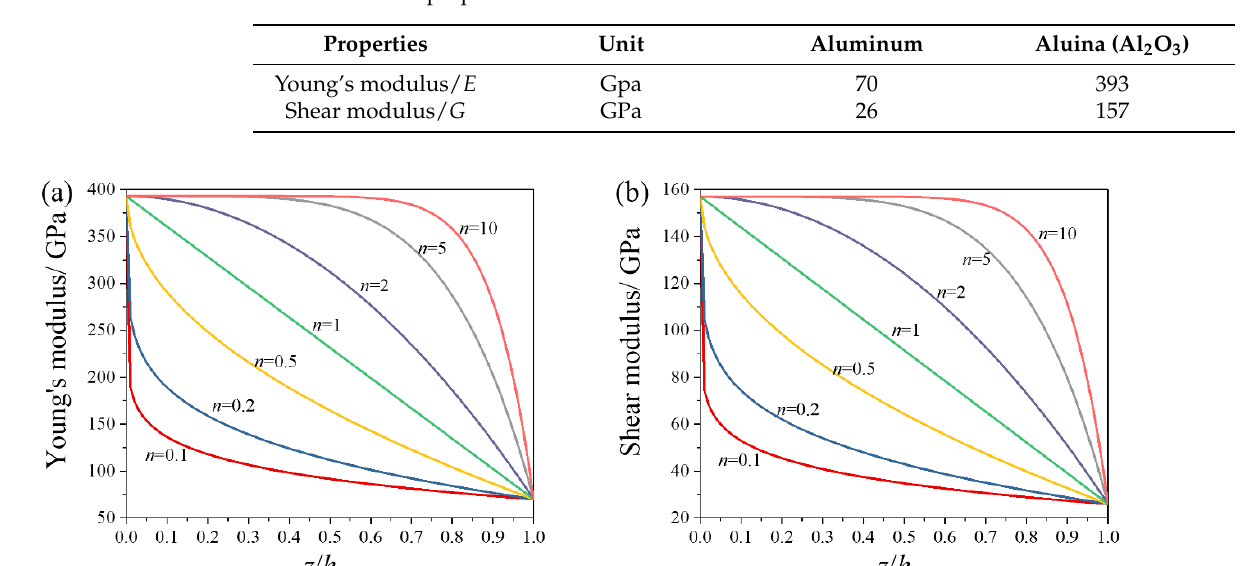
Table 1. Material properties of FGM constituents.